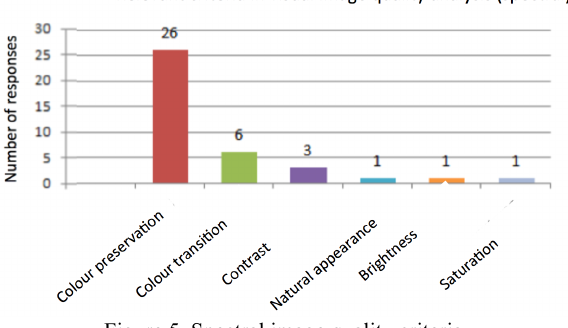
Figure 5. Spectral image quality criteria